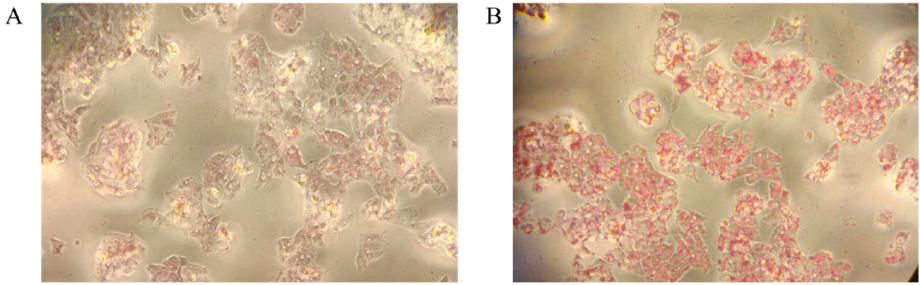
Figure 1. ( A ) Oil red O staining for the detection of lipid accumulation in induced steatotic HepG2 (20 × optical zoom). ( B ) Effect of oleic acid on TG content HepG2; the TG content in the cells increased significantly after the treatment with 0.6 mM OA compared with the control group.